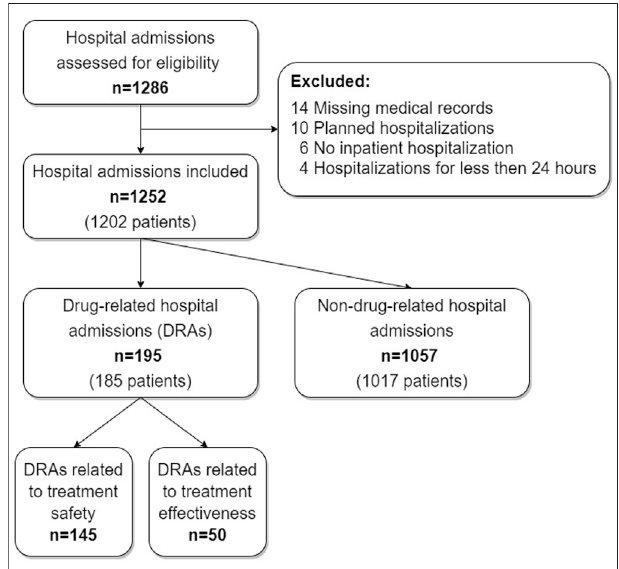
FIGURE1 | A fl ow diagram depicting thenumber ofhospital admissions at each step of the